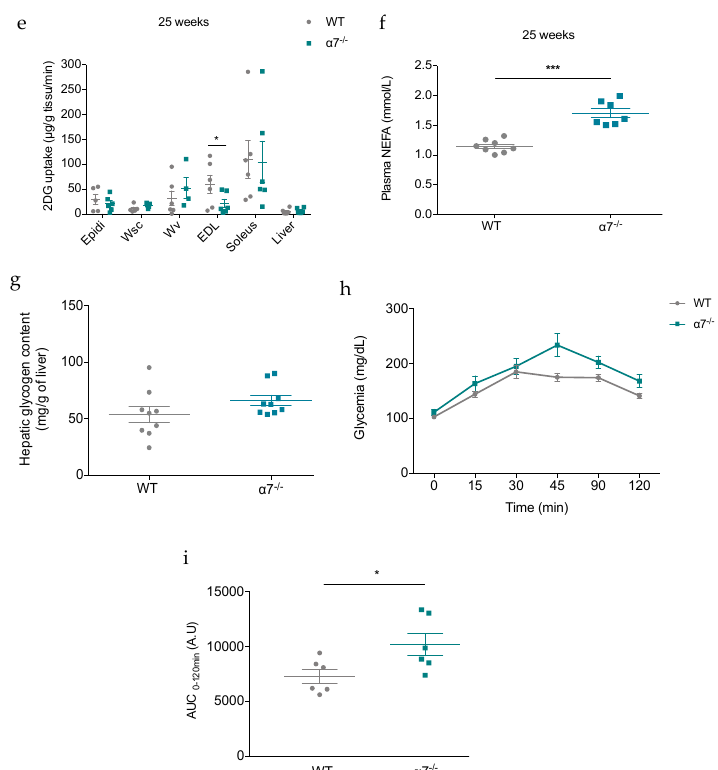
Figure 3. Twenty-five-weeks-old α 7 − / − mice develop insulin resistance. All experiments in this figure were carried out in 10- and 25-week-old male WT control and α 7 − / − mice. Insulin tolerance tests (0.75 U / kg) were performed in mice fasted 6h ( a , b ). Blood samples were taken at the time indicated from the tail vein of the same animals and the area over the curve of blood glucose levels was calculated during 120min ( c , d ). Insulin-stimulated 2DG uptake in epididymal (Epidi), subcutaneous (Wsc) and visceral (Wv) adipose tissues, livers, and soleus as well as EDL muscles from 25-week-old WT control and α 7 − / − mice ( e ). Comparison of plasma NEFA concentration from 25-week-old WT control and α 7 − / − mice ( f ) and of hepatic glycogen content ( g ). Blood glycemia was measured following intraperitoneal injection of 1g / kg sodium pyruvate ( h ) and the area under the corresponding curve was calculated ( i ). Each dot represents a mouse (grey dots for WT mice and green squares for α 7 − / − mice). All data are presented as mean ± SEM. Symbols * and *** indicate a significant di ff erence compared to control WT using unpaired Mann–Whitney two-tailed test ( c , d , f – h n = 4–9 / group, * p < 0.05; *** p < 0.001) and Multiple t tests (e, n = 5–7 / group, * p < 0.05). AOC, area over